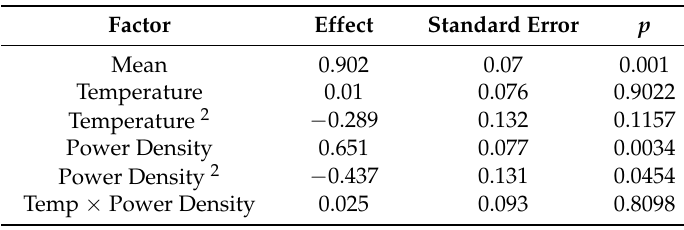
Table 4. Analysis of the perturbation of factors for the cloud value in acerola juice subjected to ultrasound processing.